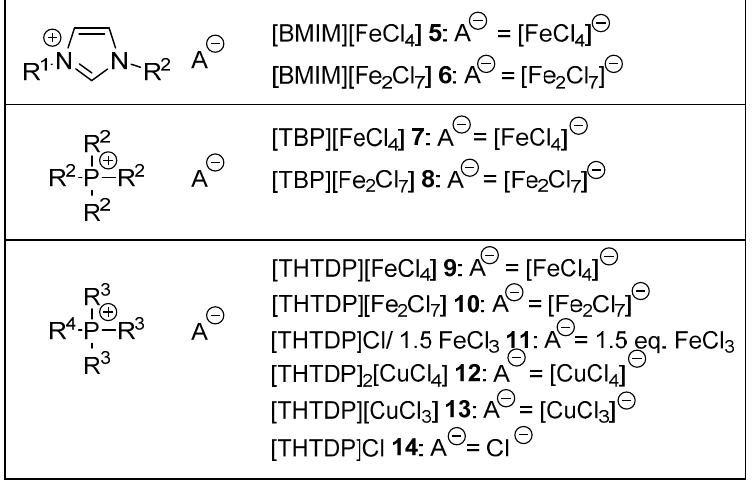
Scheme 1. Structures of metallic ionic liquids.